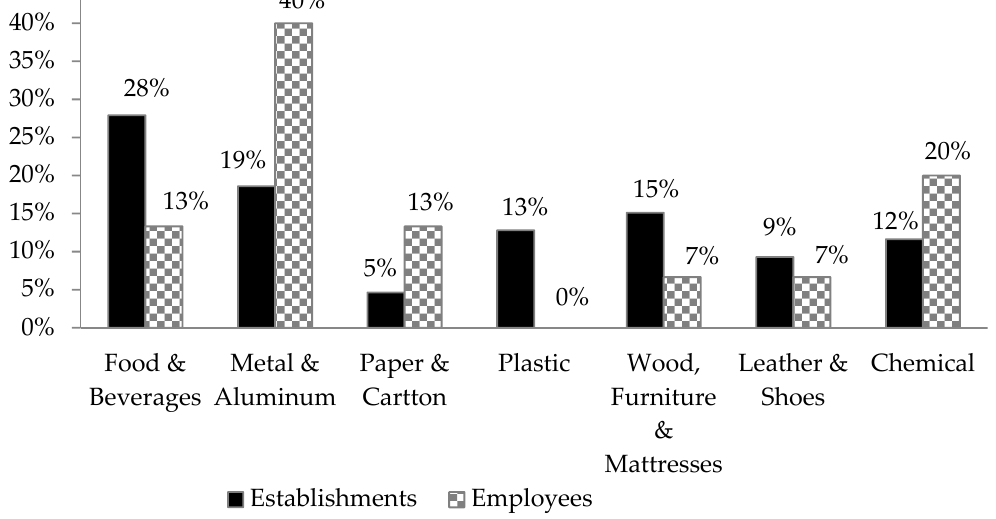
Figure 7. The occupational diseases’ percentages per industrial sector according to the employees and their employers.